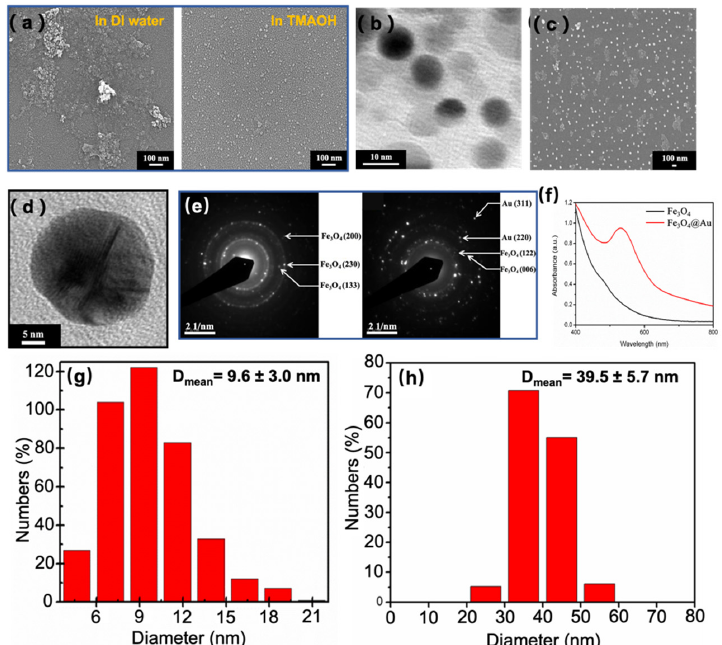
Figure 1. SEM images of the Fe 3 O 4 NPs: ( a ) in DI water (left) and 0.1 M TMAOH (right). ( b ) TEM images of the Fe 3 O 4 NPs. ( c ) SEM image of the Fe 3 O 4 @Au NPs. ( d ) TEM image of the Fe 3 O 4 NP-processed coating Au nano-shell. ( e ) SAED patterns of the Fe 3 O 4 NPs and Fe 3 O 4 @Au NPs. ( f ) UV-Vis spectrum of the Fe 3 O 4 NPs and Fe 3 O 4 @Au NPs. ( g ) Size distribution of the Fe 3 O 4 NPs and ( h ) the corresponding size distribution of the Fe 3 O 4 @Au NPs.